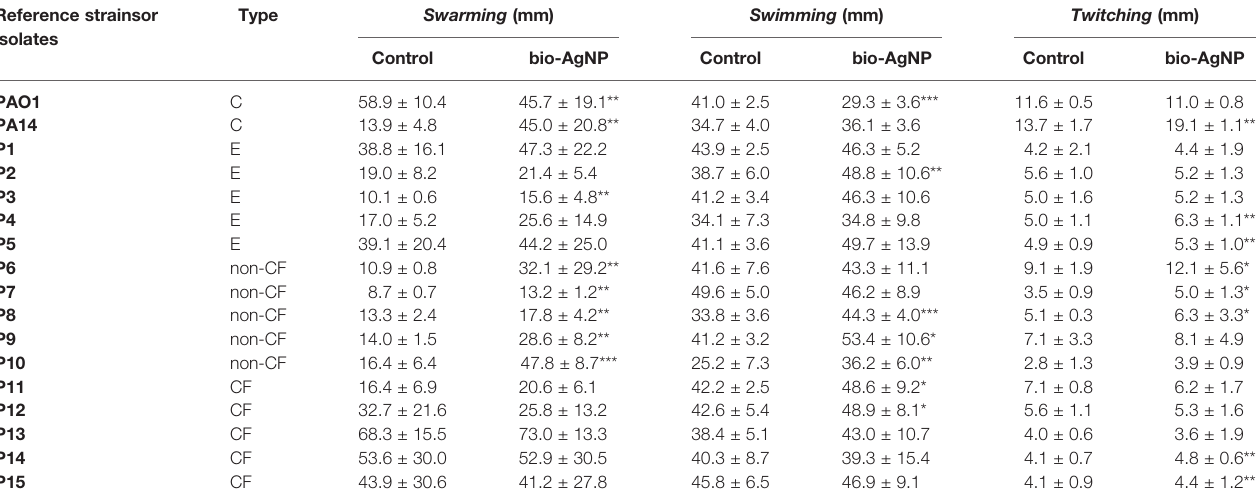
The results were obtained by the mean ± standard deviation of three independent experiments. *P < 0.05, ** < 0.01, and *** < 0.001, comparing the control bacteria (without treatment) with the treated (bio-AgNP). Bio-AgNP, silver nanoparticles. C, clinical isolates. E, environmental isolates. Non-CF, clinical isolates obtained from non-cystic fi brosis patients. CF, clinical isolates obtained from cystic fi brosis